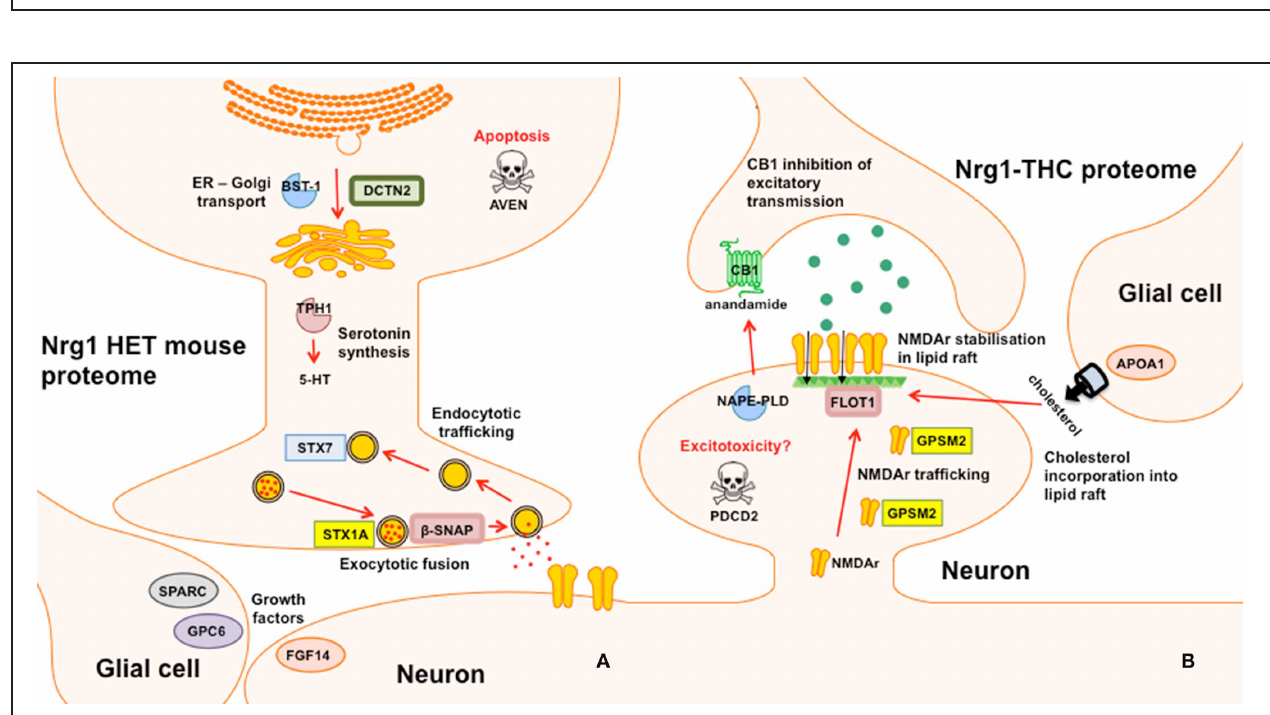
FIGURE 3 | Adolescent hippocampal proteomics comparing adolescent Nrg1 HET mice treated with vehicle and THC. (A) Representative 2D E gel images showing positions of significantly altered protein spots (the horizontal axis split by isoelectric point,